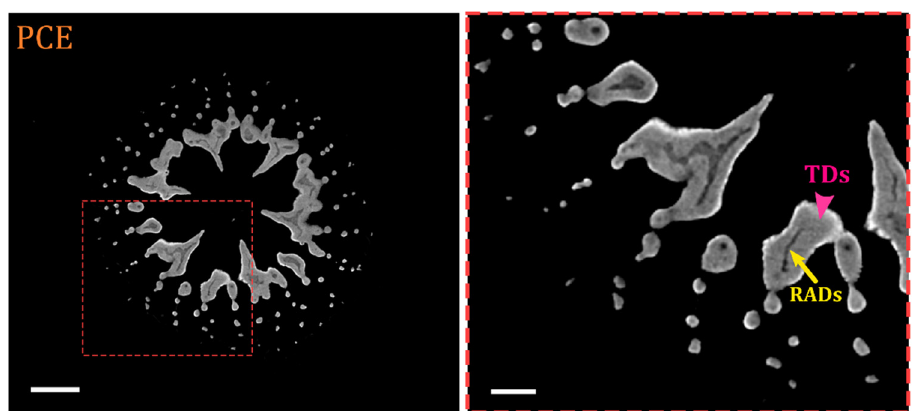
Figure 4. Typical coral skeleton details observed in cross-sectional tomography slices and comparison between absorption and PCE imaging modes. Differences in X-ray absorption within the skeleton reveal variations in both mineral distribution and density between RADs (darker regions correspond to lower density) and TDs (lighter regions, higher density); the red marked insets are shown on the right. Strongly defined boundaries can be observed between RADs and TDs in slices from PCE-CT datasets, whereas absorption images provide a blurry, poorly distinguishable separation between the two skeletal regions. Scale bars: 300 µm ( left images ), 100 µm ( right images ).